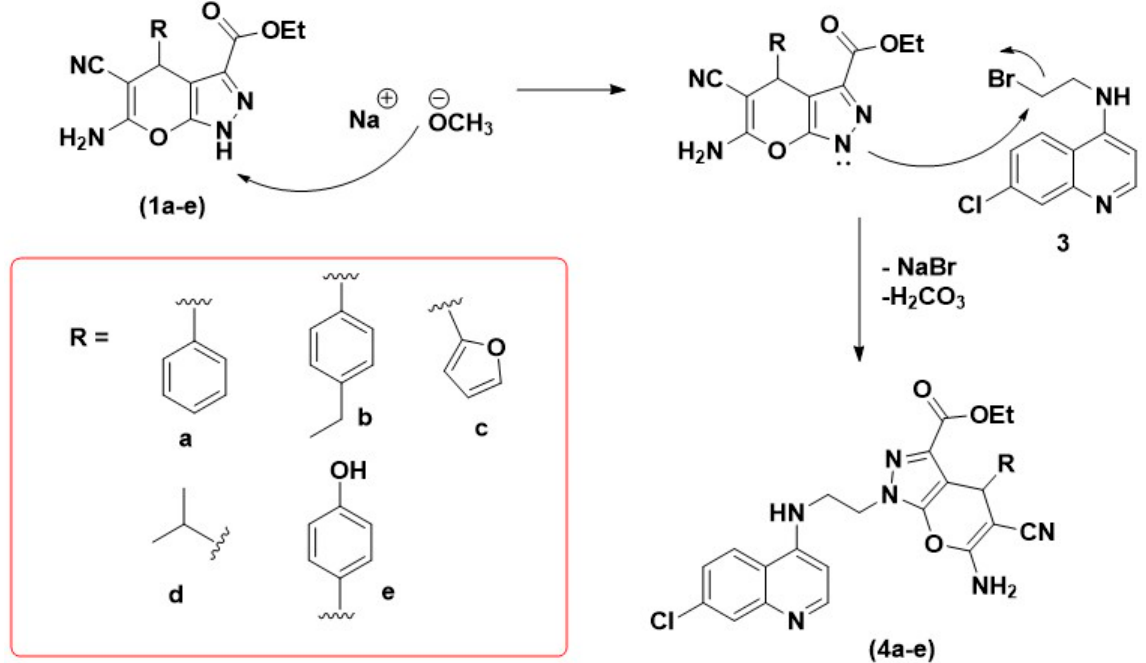
Figure 3. Proposed nucleophilic attack of pyrano[2,3-c]pyrazole derivatives to the 4-aminoquinoline scaffold to obtain the molecular hybrids ( 4a – e ).